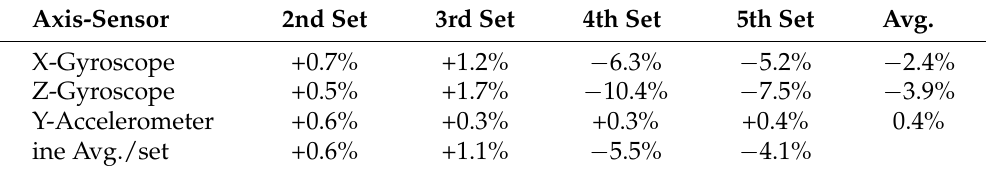
Table 3. The percentage of muscular endurance changes represented in vertical